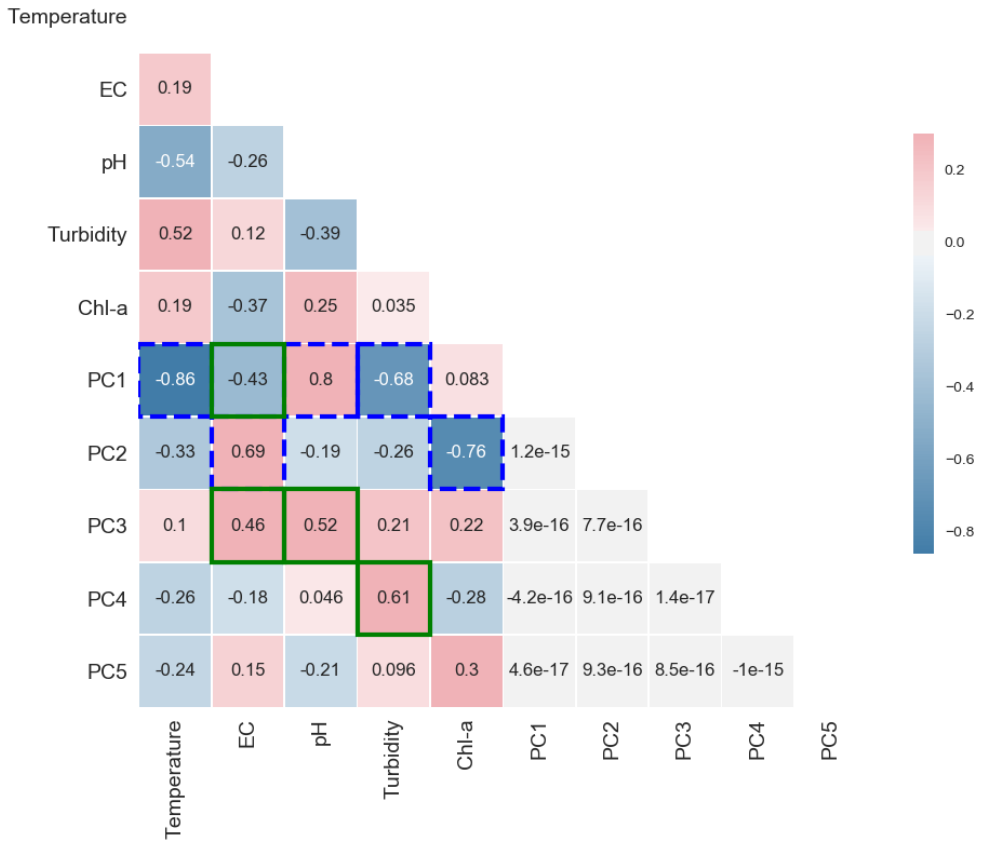
Figure 7. Correlations between water quality variables and principal